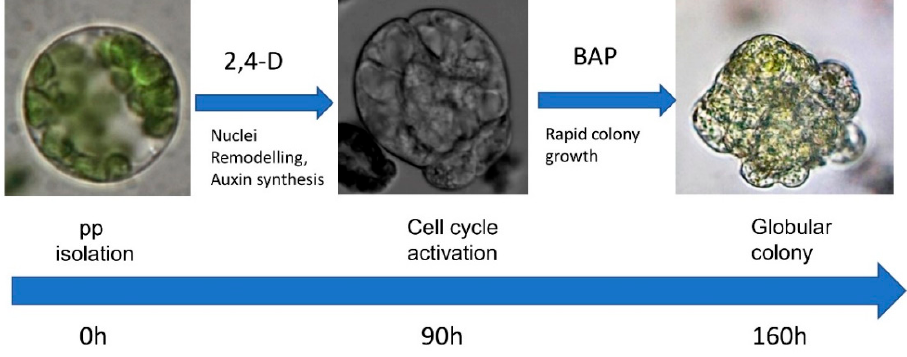
Figure 5. Pipeline for Arabidopsis shoot-derived protoplast cultivation.